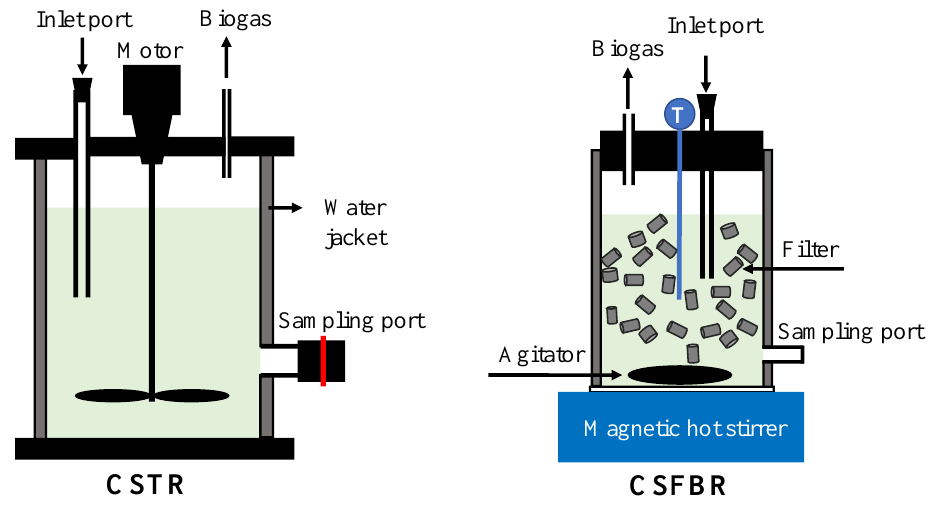
Figure 1. Schematic diagram of the CSTR and CSFBR.